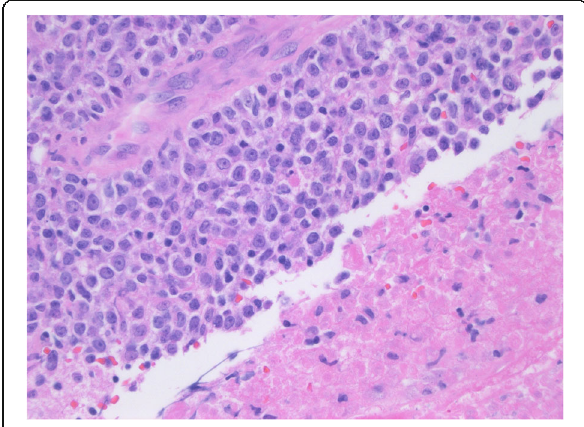
Fig. 1 Monomorphic primary central nervous system post-transplant lymphoproliferative disorder. Photomicrograph of the specimen shows sheets of large cells which are adjacent to an area of coagulation necrosis, a common finding in biopsies of primary central nervous system post-transplant lymphoproliferative disorder. This monomorphic case could also be called diffuse large B cell